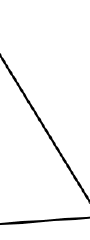
Figure 3. Flank wear width of end ‐ mill based on ISO 8688 ‐